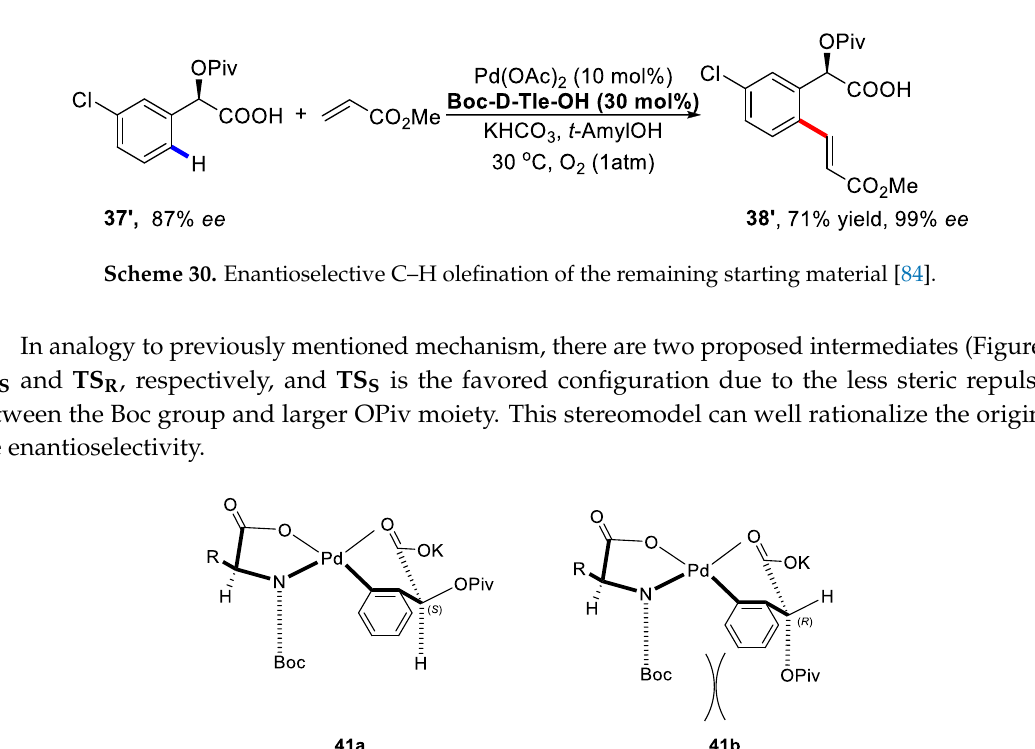
Figure 6. The proposed intermediate state. Reproduced from Reference [84].